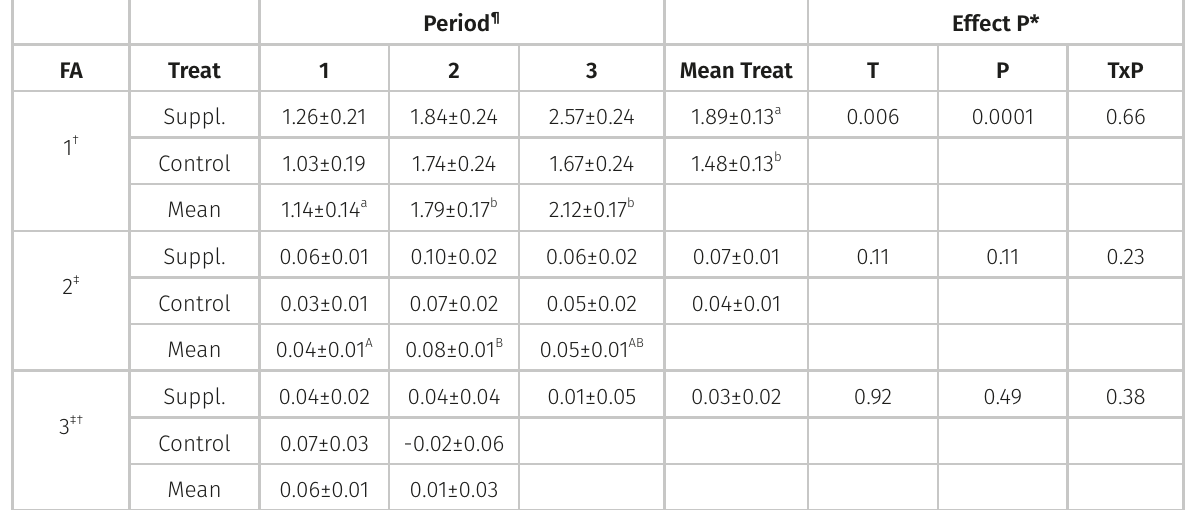
Table II. Effect of linseed-based vegetable oil with addition of salmon oil Canada supplementation on the plasma concentrations of polyunsaturated Omega 3 fatty acid (%) in Mangalarga Marchador mares. Period ¶ Effect P* FA Treat 1 2 3 Mean Treat T P TxP Suppl.